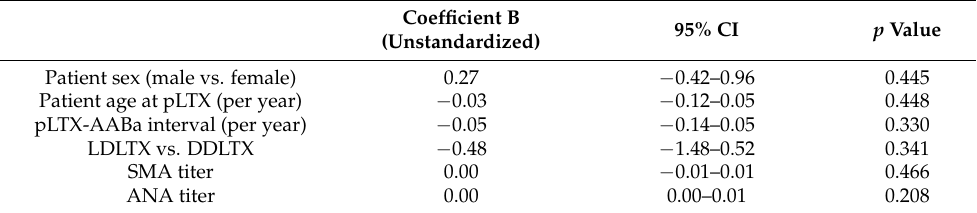
Table 4. Characteristics associated with RAI score (0–9) in multiple linear regression (n = 112). Coefficient B 95% CI p Value (Unstandardized) Patient sex (male vs. female) 0.27 − 0.42–0.96